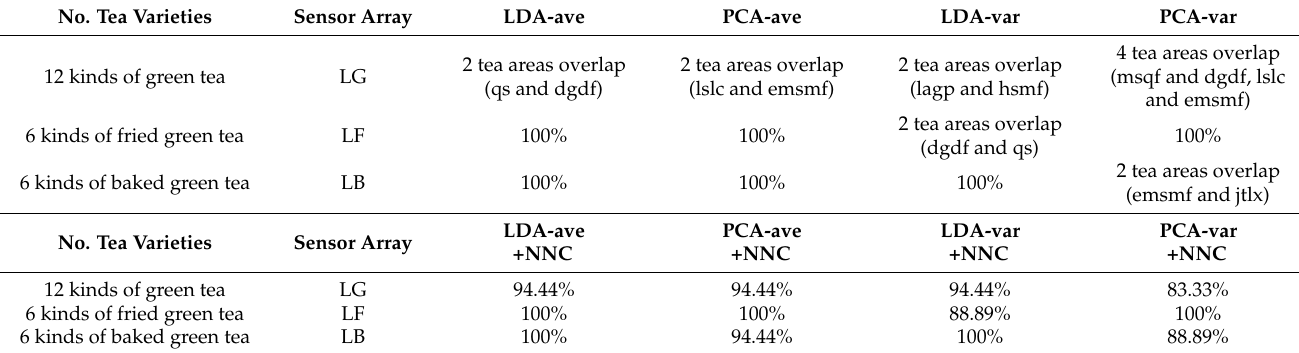
Figure 10. Classification results of green tea identified using LG. Table 9. Discrimination accuracy of tea varieties by sensor array optimized for specific kinds of